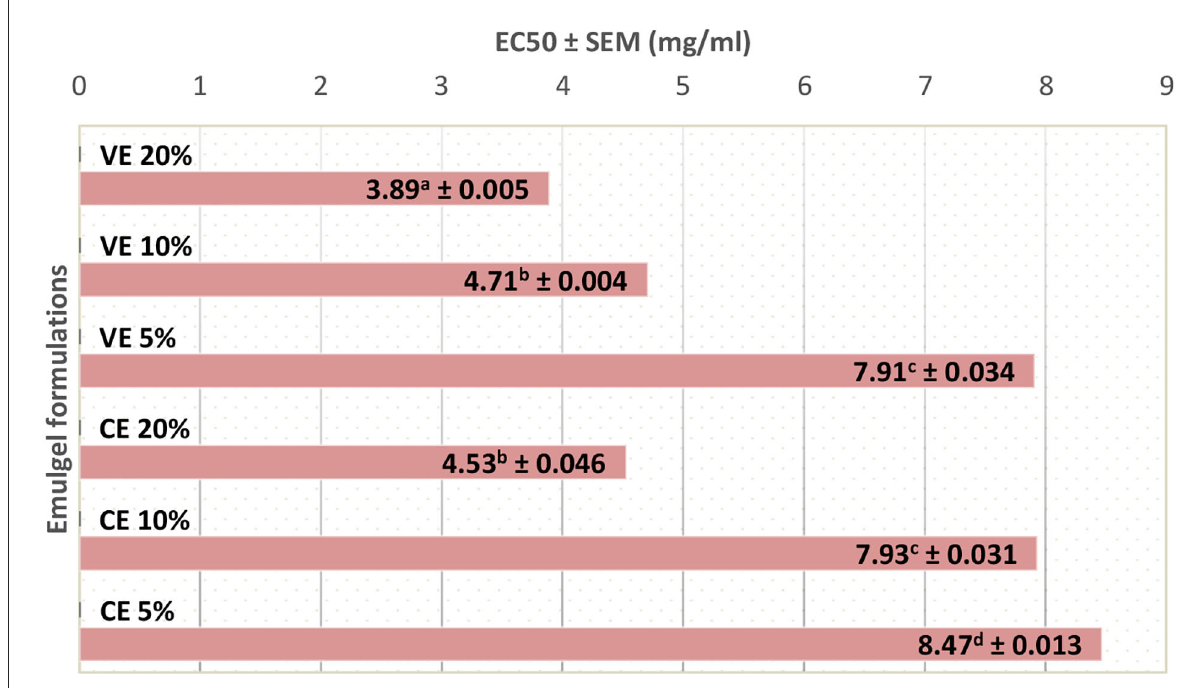
FIGURE1 Antioxidant and radical scavenging activity of emulsion formulations against the DPPH radical. VE 20%: vitamin E emulgel at 20%, VE 10%: vitamin E emulgel at 10%, VE 5%: vitamin E emulgel at 5%, CE 20%: Copoazú seed butter emulgel at 20%, CE 10%: Copoazú seed butter emulgel at 10%, and CE 5%: Copoazú seed butter emulgel at 5%. n = 3. Different superscripts indicate a significant difference ( p < 0.05) among